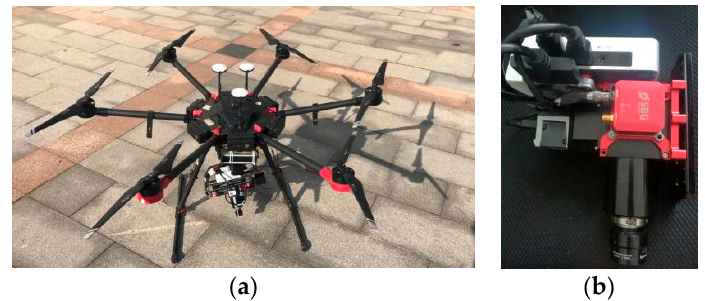
Figure 2. ( a ) The M600 PRO unmanned aerial vehicle (UAV) equipped with the Pika L; ( b ) the Pika L with the integrated Ellipse2-D inertial sensor.